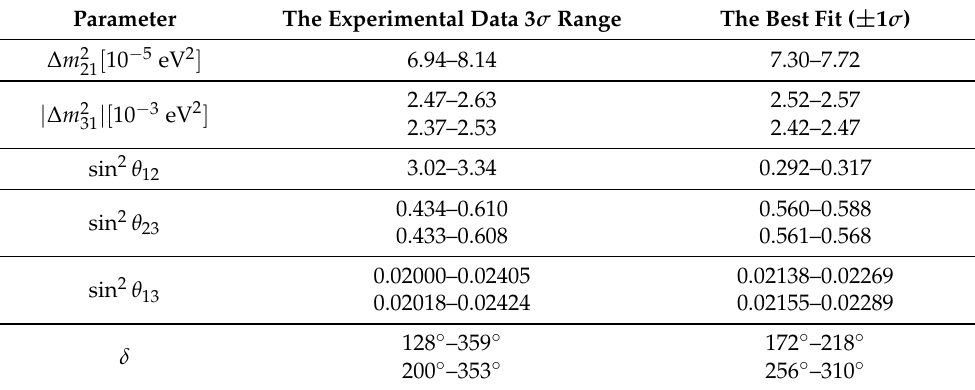
Table 1. The experimental data for the neutrinos mixing parameters. When multiple sets of allowed ranges are stated, the upper row corresponds to normal hierarchy and the lower row to inverted